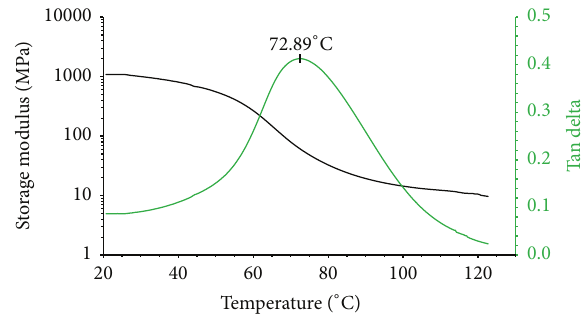
Figure 4: DMA plots of the X-EMACO-Styrene copolymer.